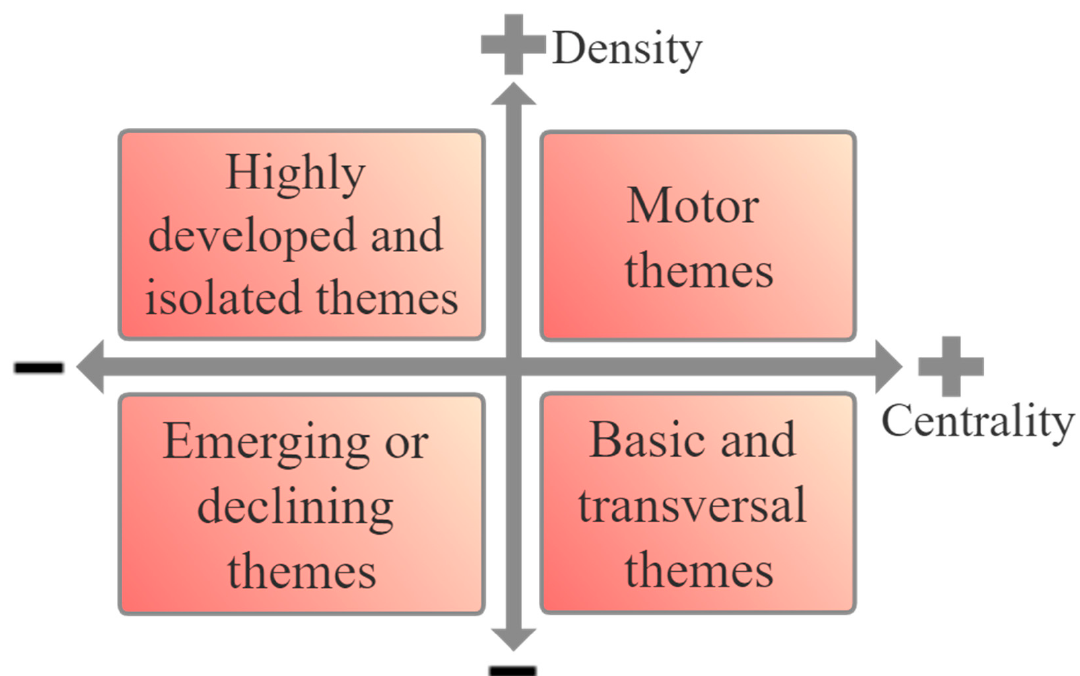
Figure 2. Strategic diagram.